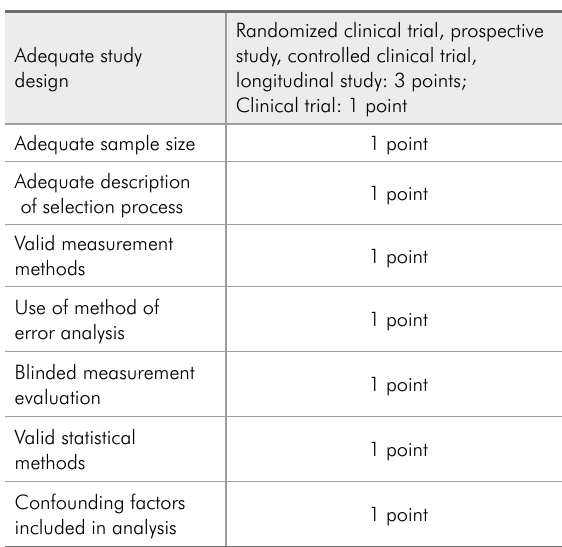
Table 1 - Scores used for quality analysis of papers se-